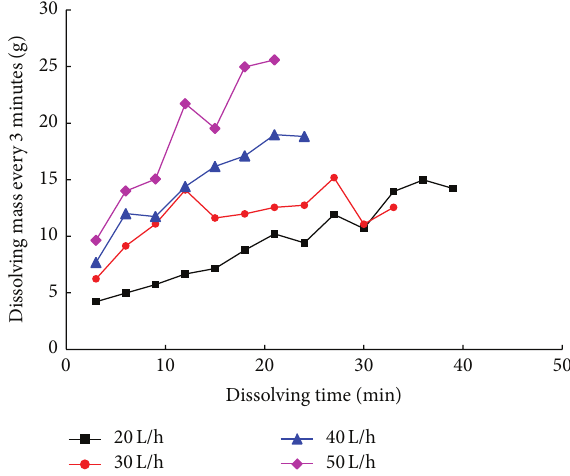
Figure 4: The curve of test specimen’s dissolving mass every 3 minutes under different flow quantity.